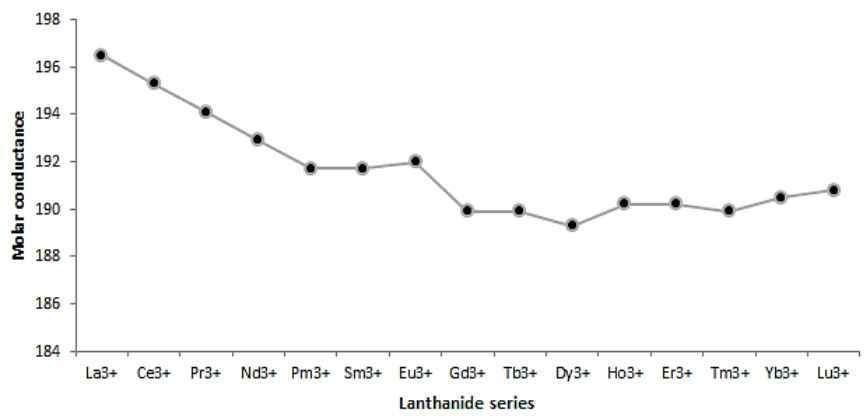
Fig. 3: The infinitive molar conductance (×10 −4 S m 2 mol -1 ) of lanthanide series.